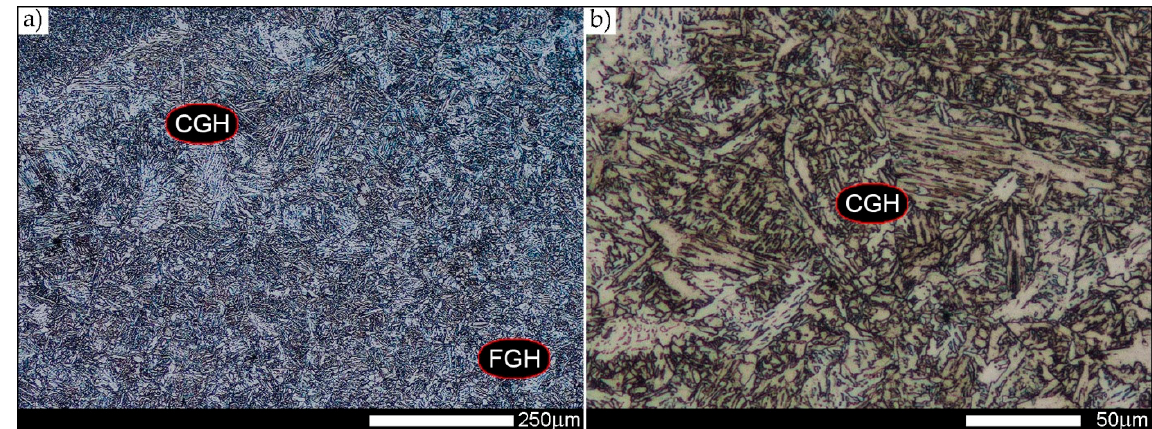
Figure 10. Microstructure of welded joint of Hardox 450 steel in delivery state (directly after welding)—CGH(HAZ) zone shown in Figure 2a. ( a ) 100×; ( b ) 500×. Diversified structure consisting of sorbite and locally quenching martensite. The martensite shows a packet structure with the same crystallographic orientation of the formed blocks within the prior austenite grain boundaries. CGH(AZ)—coarse-grained zone, FGH(AZ)—fine-grained zone. Light microscopy, etched with 3% HNO 3 .